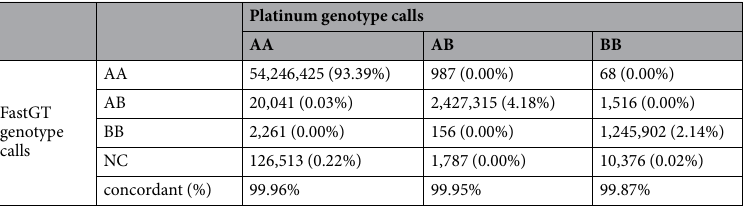
Table 2. Concordance between the autosomal genotypes of two individuals from the Platinum dataset and bi-allelic FastGT genotypes called from the same individuals. The reference allele is denoted by “A” and the alternative allele is denoted by “B” denotes the alternative